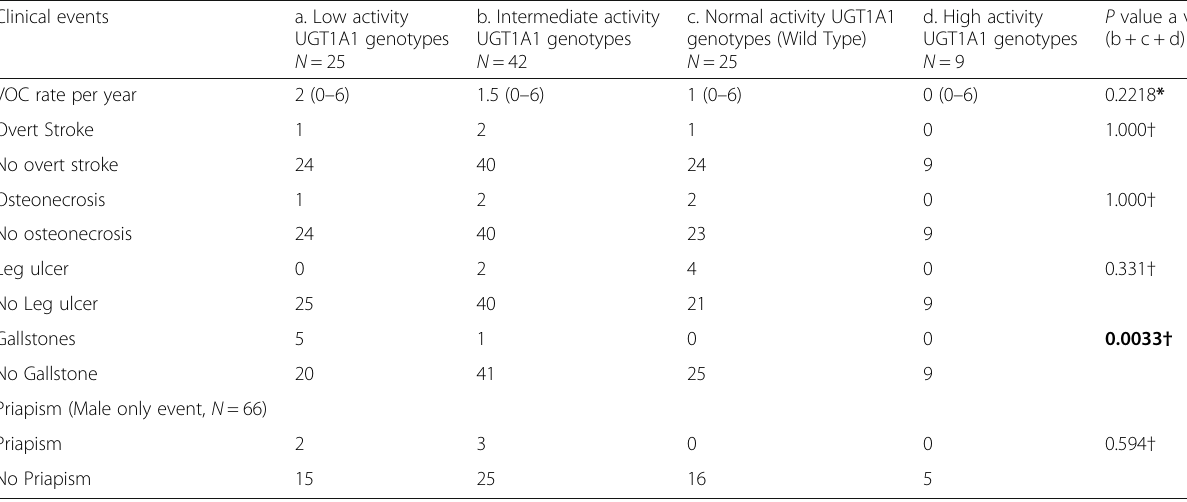
Table 3 Influence of UGT1A1 (TA) n genotype on clinical events of patients Clinical